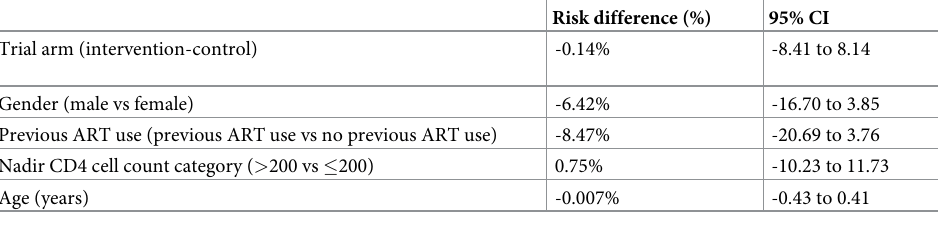
Table 6. Generalized estimating equations with additive binomial regression (clustered by adherence club to which participants randomised to the intervention arm were referred) predicting future VL > 400